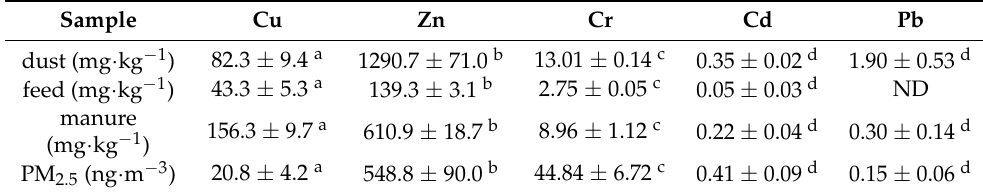
Table 2. Summary of quantitative determination results of heavy